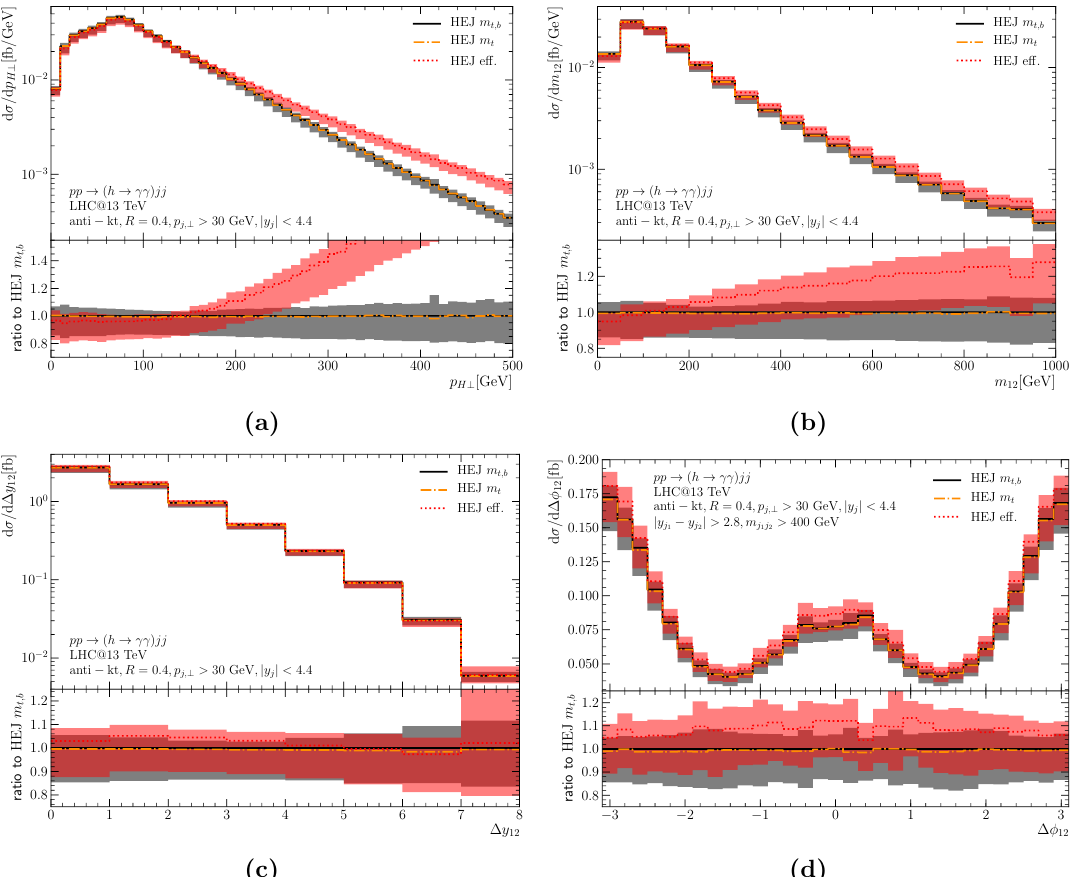
Figure 14 . HEJ predictions for various distributions and di(cid:11)erent choices for the heavy-quark mass with the central scale choice (cid:22) r = (cid:22) f = H T = 2. See (cid:12)gure 10 for the corresponding plots with (cid:22) r = (cid:22) f = max( m H ; m 12